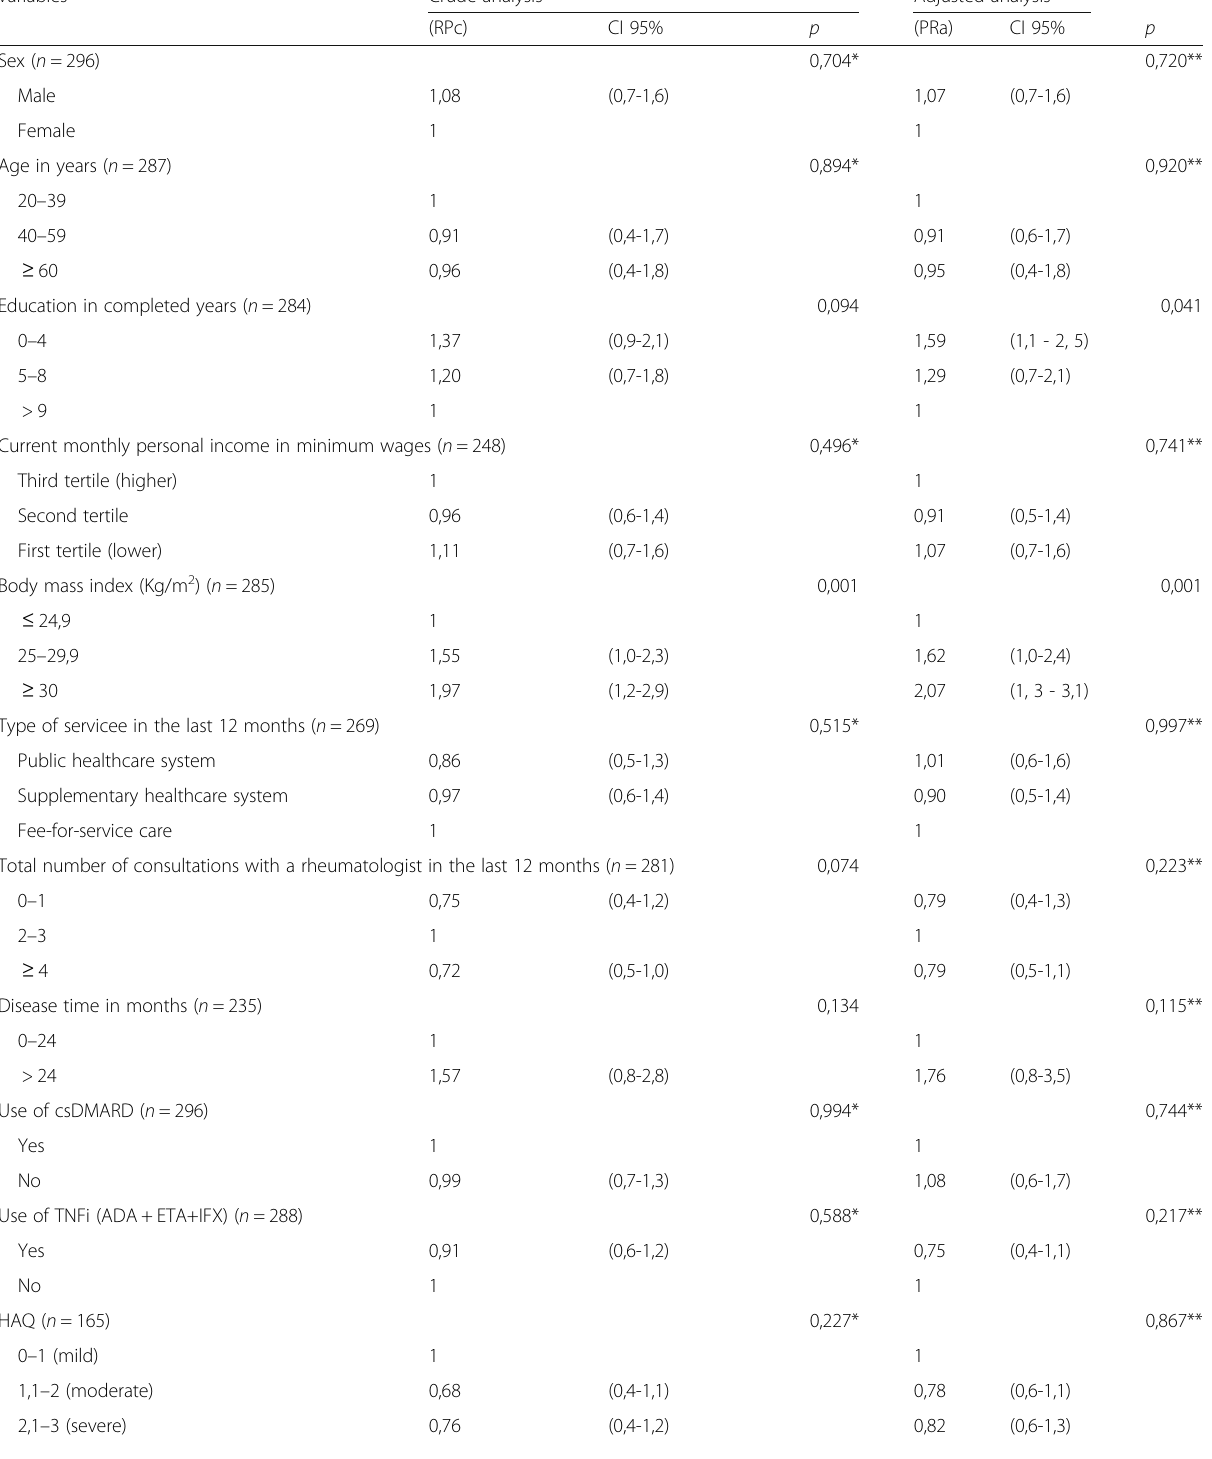
Table 3 Crude and adjusted regression analysis of diagnostic time up to 12 months and independent variables in patients with rheumatoid arthritis in Blumenau, Santa Catarina, Brazil,